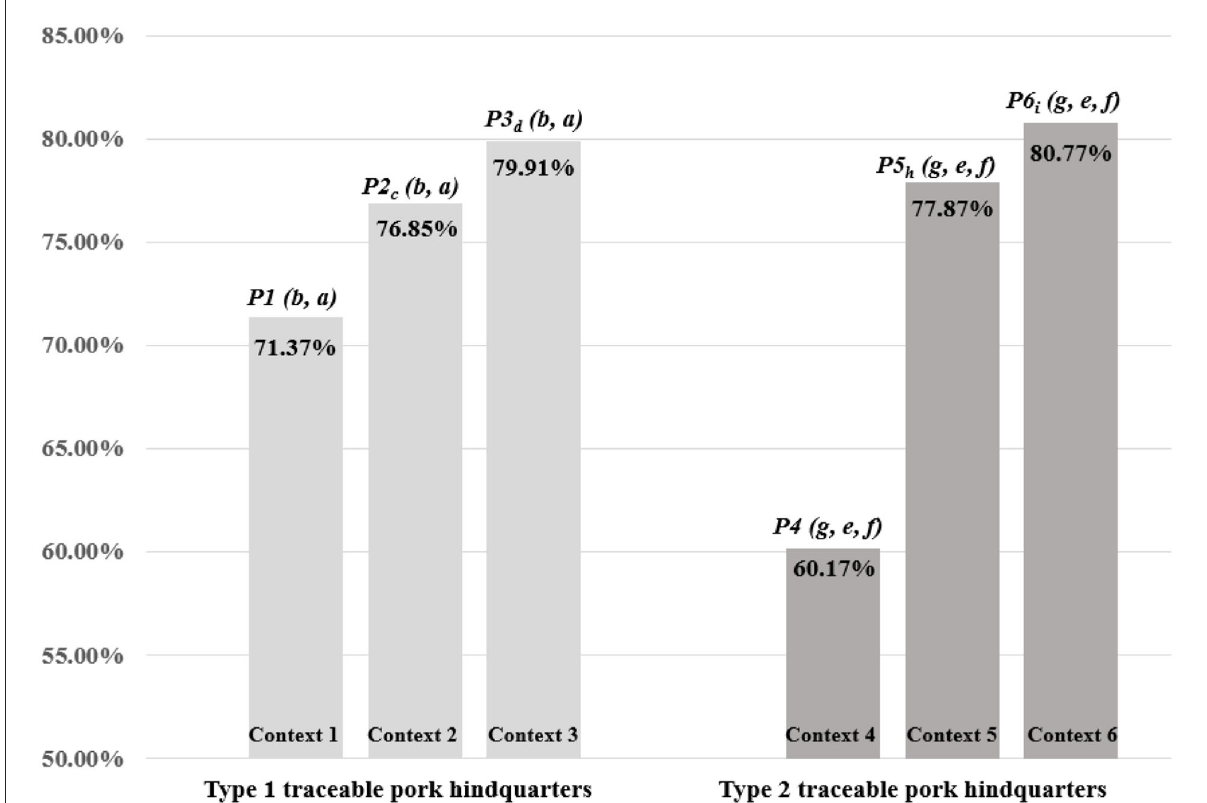
FIGURE3 Decoy effect in types 1 and 2 traceable